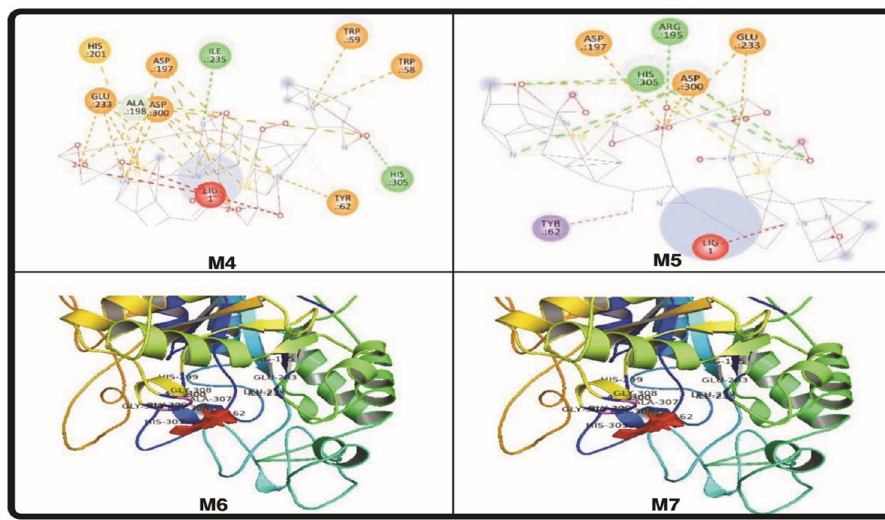
Fig 4. In-silico molecular docking of ligand with alpha amylase